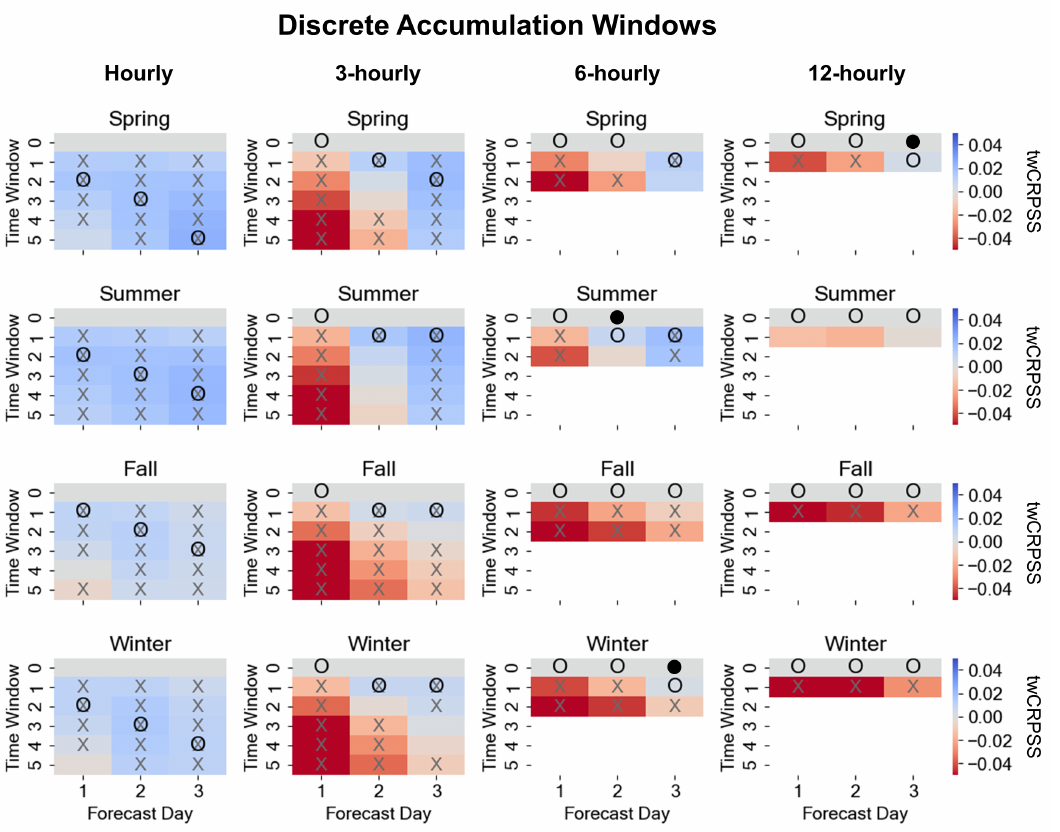
Figure 5. Heatmaps of station-averaged twCRPSS for hourly to 12-hourly discrete accumulation windows using τ between 1 and 5 to consider temporal trend similarity (TTS) for all seasons and forecast windows. Blue (red) colors indicate better (worse) average twCRPS compared to the reference using τ = 0 (no TTS). Crosses “X” mark significant differences in twCRPS station distributions compared to the reference. Empty circles mark the value τ that exhibits best improvement overall, and filled circles correct the position of best τ if the value in the empty circle is not